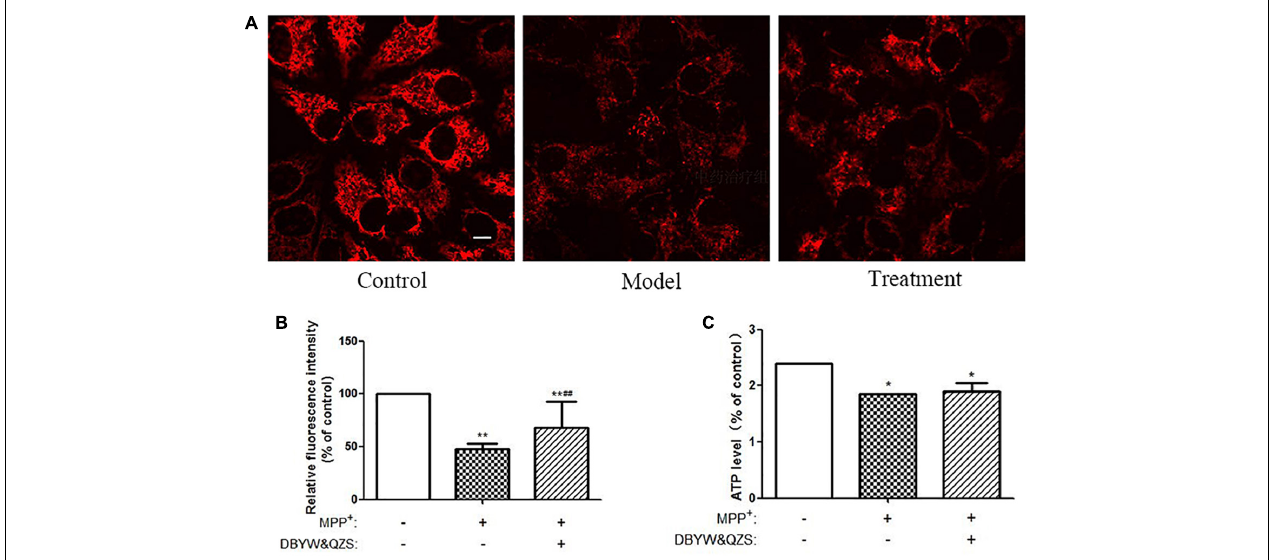
FIGURE 3 | Analysis of mitochondrial function. (A) Changes of Mitochondrial Membrane Potential in different groups. TMRM was adopted to label mitochondria of living cells. Adjust LUT to select Jet. The bar was 10 µ m. (B) Relative fluorescence intensity in each group. (C) Relative ATP level of the cells in each group. Data were expressed as mean ± SD ( N = 3). Compared with the control group, ∗ P <